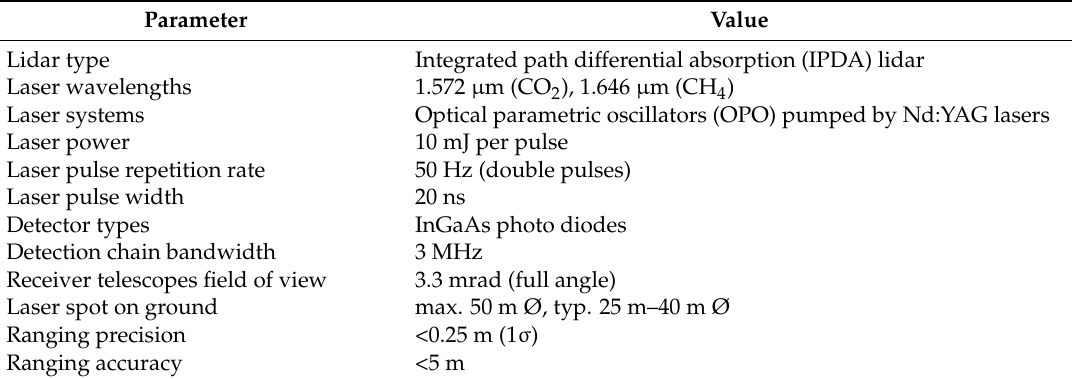
Table 1. CHARM-F’s main system parameters.